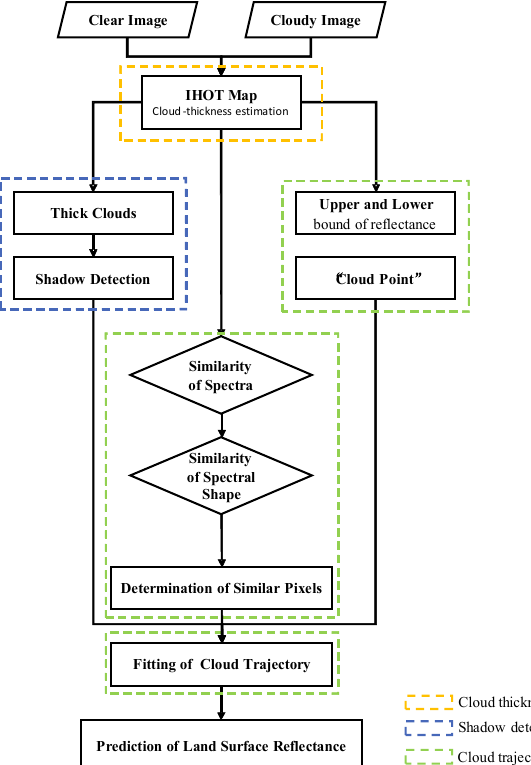
Figure 2. Flowchart of the proposed method.